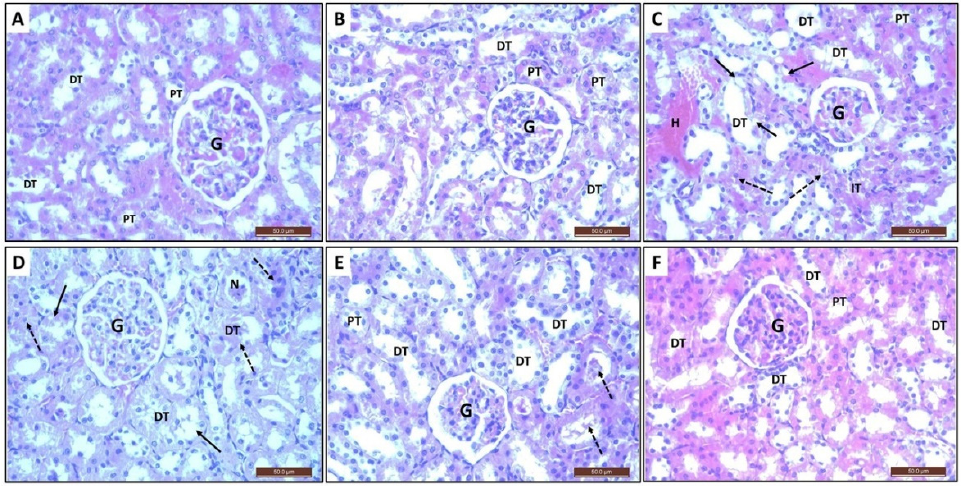
Figure 6. Photomicrographs of renal tissues of all study groups stained with H/E. ( A , B ): Control and OLE group respectively showing the normal histological structure of renal parenchyma. ( C ): Cis group showed tubular degenerative changes and glomerular shrinkage, focal hemorrhage, and congestion of blood vessels. ( D – F ): Cis + OLE, Cis + CM-MSC, and Cis + MSC groups, respectively. Regeneration of the epithelium of the tubules occurred in the three groups, but obviously noticed in both Cis + CM-MSC and Cis + MSC groups. G: glomerulus, DT: distal convoluted tubule, PT: proximal convoluted tubule, H: hemorrhage, IT: interstitial necrotic tissue, Arrow: vacuolation of tubular epithelium, Dashed arrow: obliterated tubular lumen with necrotic tissue.